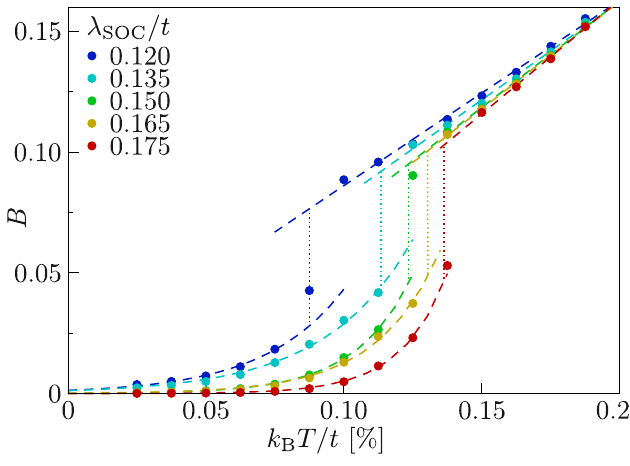
Figure 3: The value of the order parameter B as a function of temperature, at various fixed values of the spin orbit coupling strength. At low temperature the lattice is simple cubic and order is exponentially suppressed (as indicated by the exponential fits to the data), while high temperatures favour the formation of combined charge and orbital order within a trigonal lattice structure (as shown by the linear fits). The transition into the ordered state, qualitatively indicated by the dotted lines, shifts to progressively higher temperatures for increasing strength of the spin-orbit